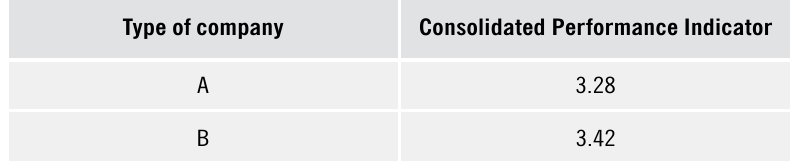
Table 5. Performance of A- and B-type